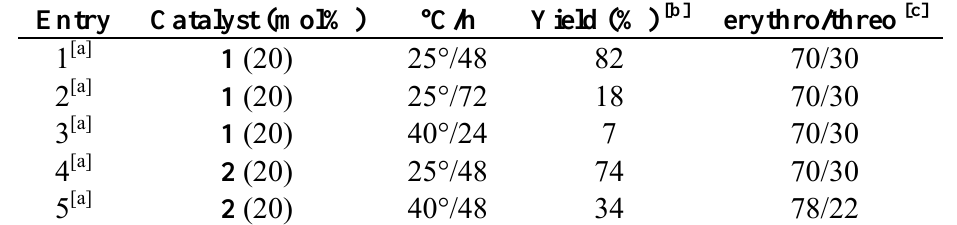
Table 2. Effects of reaction conditions on the reaction of 7 with 8a catalyzed by 1 and